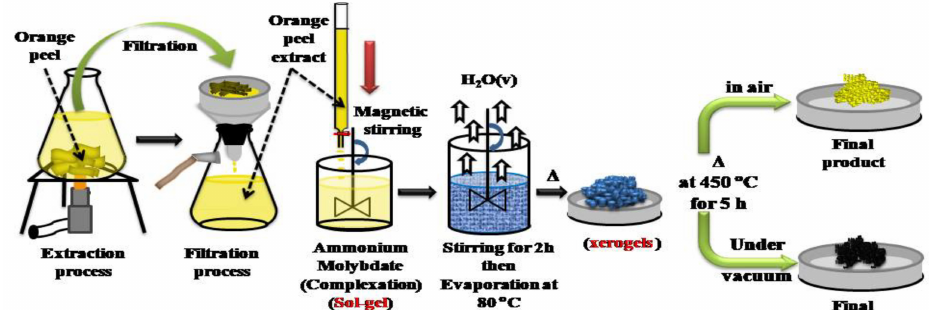
Figure 1. Schematic diagram for the synthesis of MoO 3 (yellow color) and MoO 2